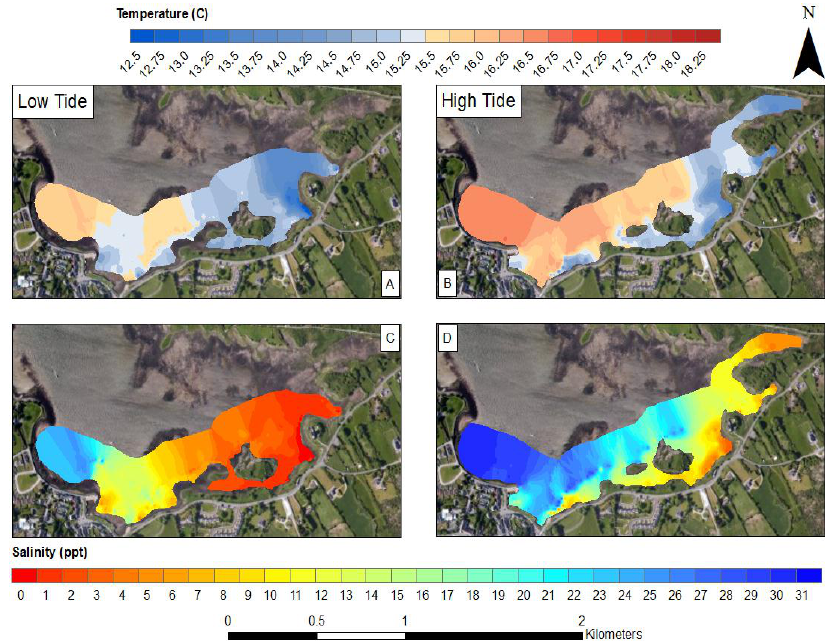
Figure 10. Sea surface temperature maps of southern Kinvara Bay interpolated from in-situ data measurements at low tide ( A ) and high tide ( B ); Sea surface salinity maps at low tide ( C ) and high tide ( D ).